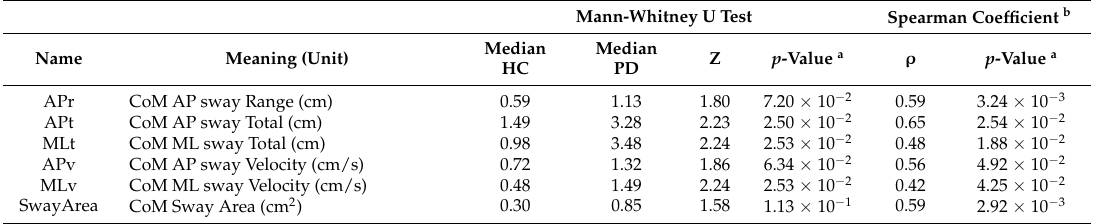
Table 8. Parameters of the PS COM task: discriminant power and correlation with UPDRS scores.